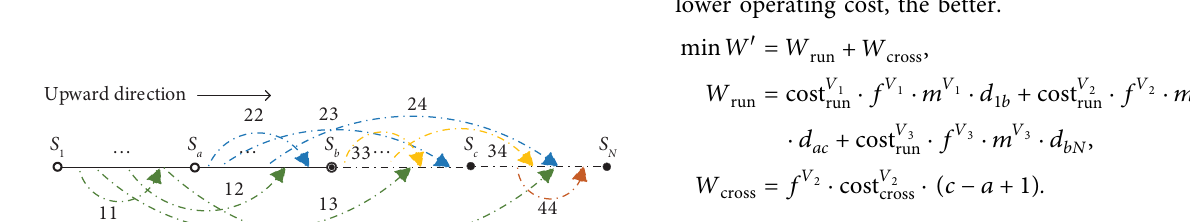
Figure 2: Division of operation lines.